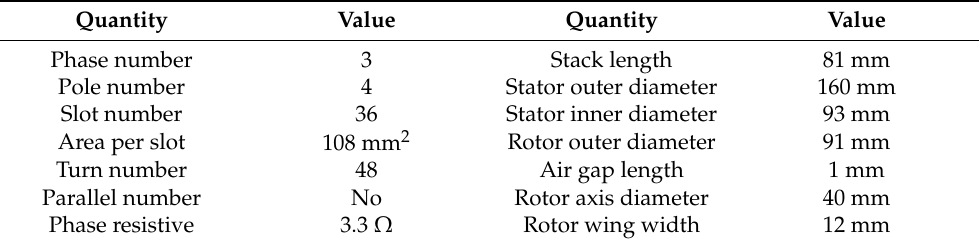
Table A1. Specifications of the experimental motor for numerical analysis and experiments.